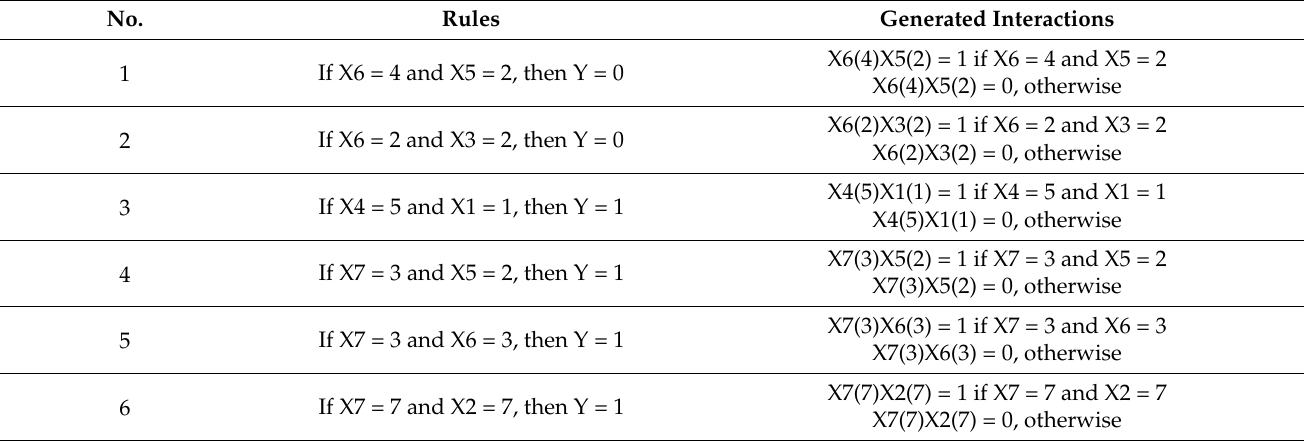
Table 9. Classifier rules generated by CBA: appendicitis